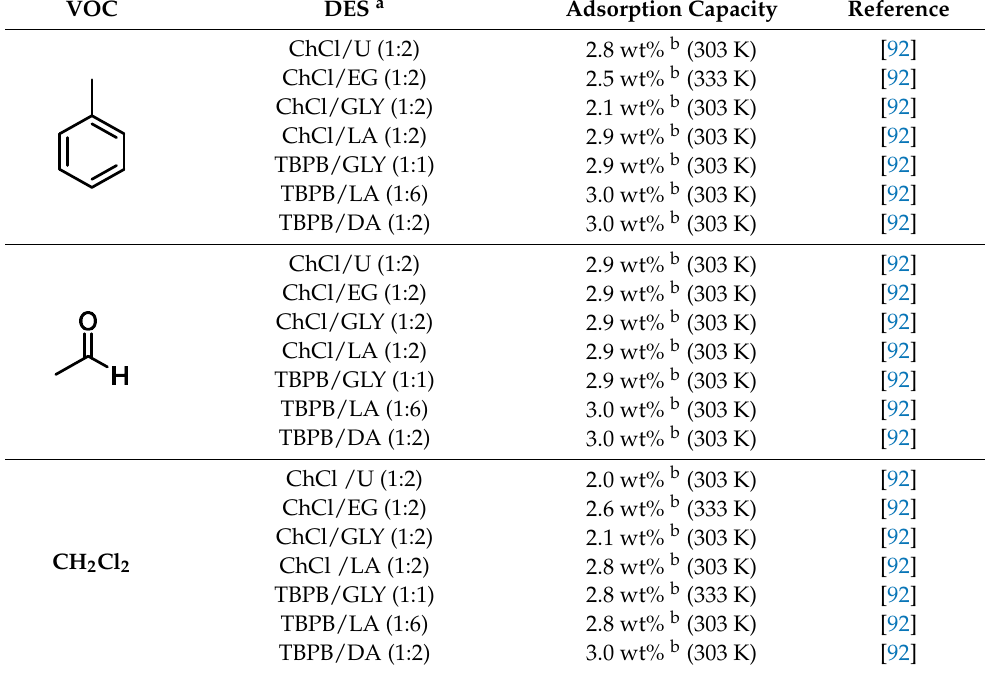
Table 5. Selected DESs employed as VOCs absorbents. The best adsorbing system in terms of temperature and pressure is herein reported.